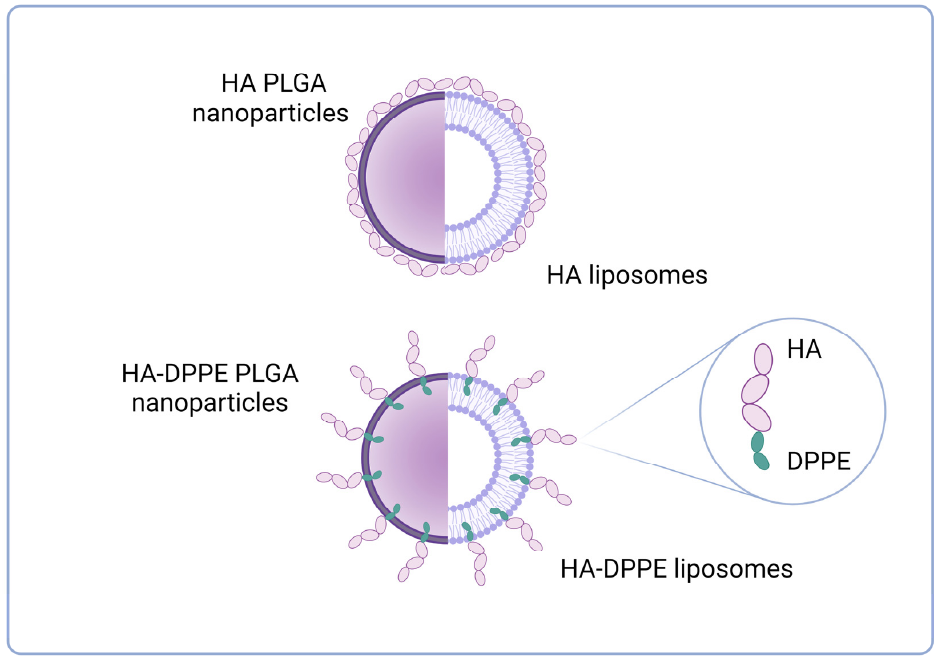
Figure 4. Schematic representation of the association of HA and HA-DPPE conjugates to polymer and lipid nanocarriers (created with BioRender.com).